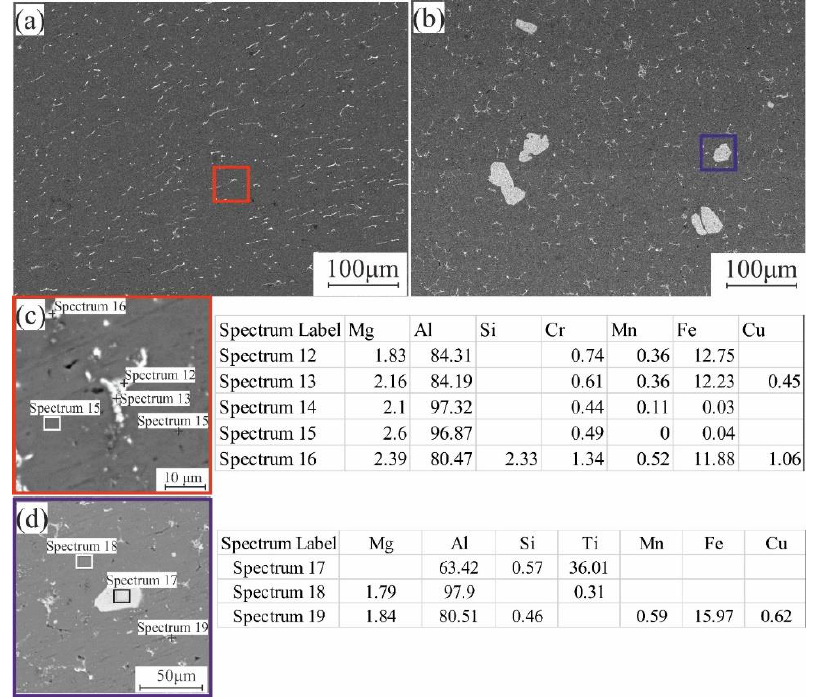
Figure 5. The as-cast SEM and EDS points analysis of investigated alloys: ( a , c ) Al-2.5% Mg alloy; and ( b , d ) Al-2.5% Mg + TiB.